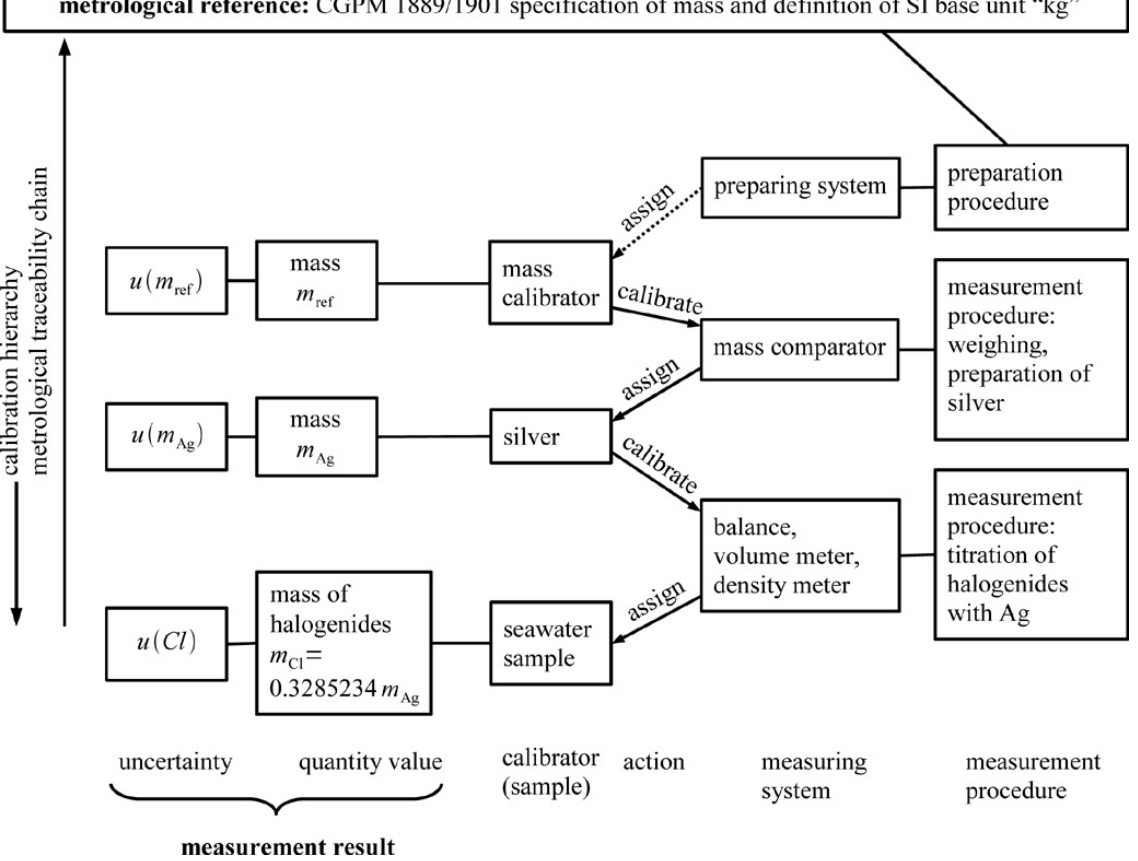
Fig. 2. Illustration of metrological traceability of Chlorinity measurement results. Notes in the caption of Fig. 1 apply accordingly. Here the metrological reference is the declaration of the “General Conference of Weights and Measures (CGPM)” held in 1889 and 1901, which specified the platinum/iridium prototype stored in Paris as “1kg”. Note that the illustration has been simplified for clarity. Depending on the titration method additional measurement results and the corresponding traceability chains must be considered, e.g. from density or volume measurements. In particular a purity measurement of the silver must be accounted for in the uncertainty calculation. Furthermore, there are typically several calibration levels between an end user’s mass calibrator and a primary mass